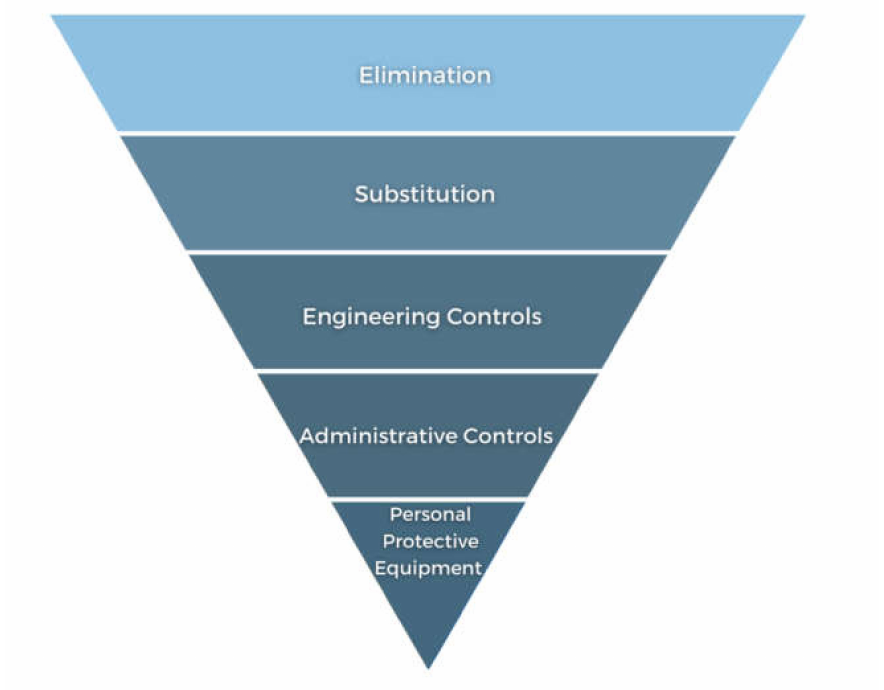
Figure 2. Hierarchy of Control (modified from the National Institute for Occupational Safety and Health)